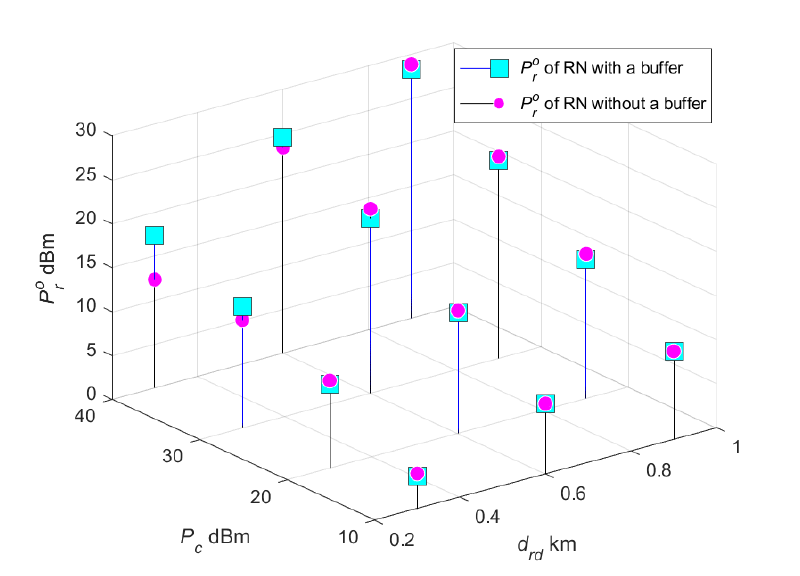
Figure 6. Optimal power P o r of RN with and without a buffer over d rd and P c , where P o r is obtained from the results in Figure 5.